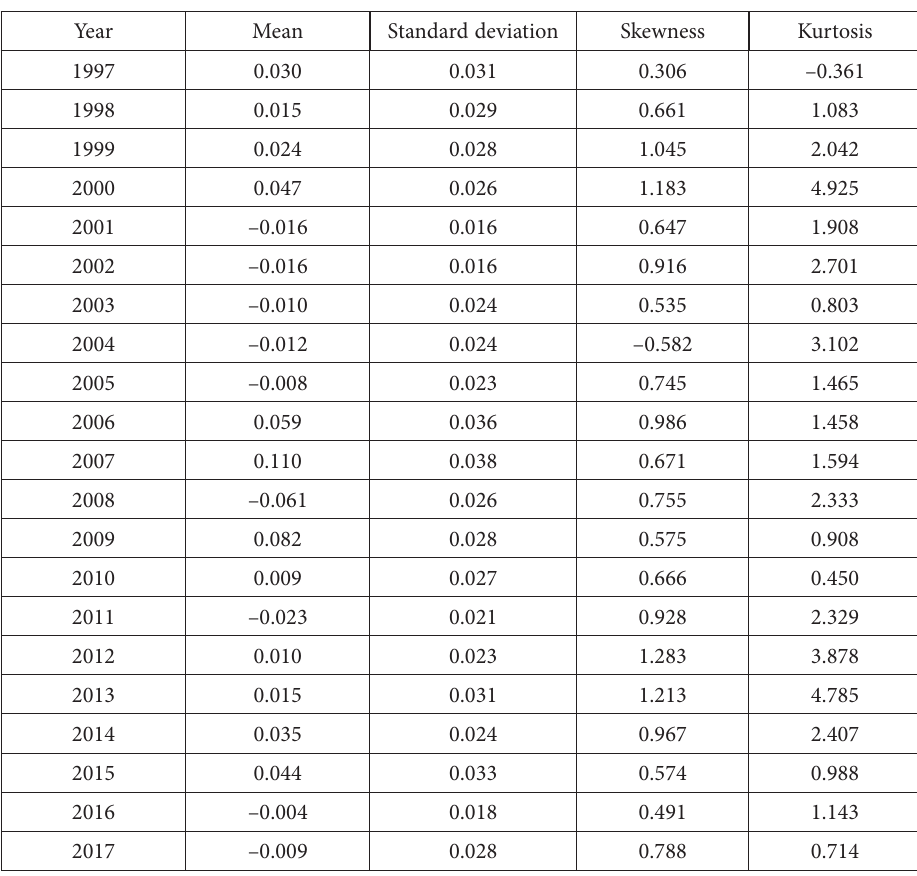
Table 2. Descriptive statistics of basic characteristics of the sample data